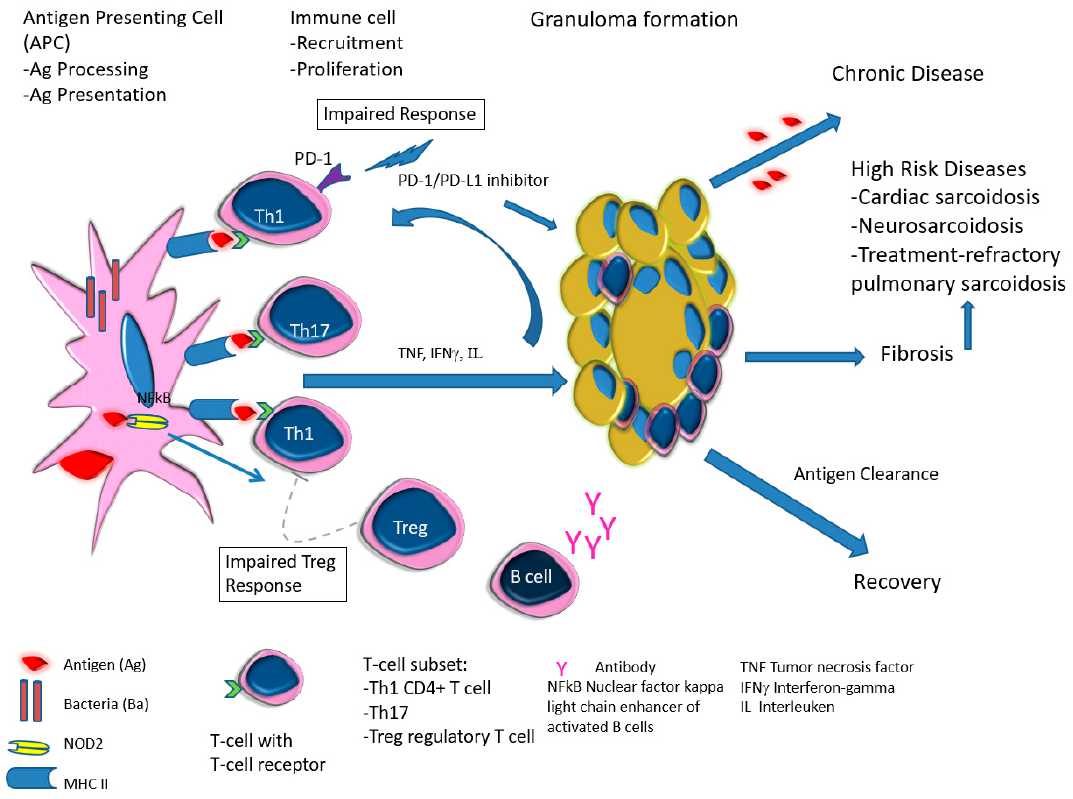
Figure 9. Proposed Pathogenetic Mechanisms in Pediatric Sarcoidosis.